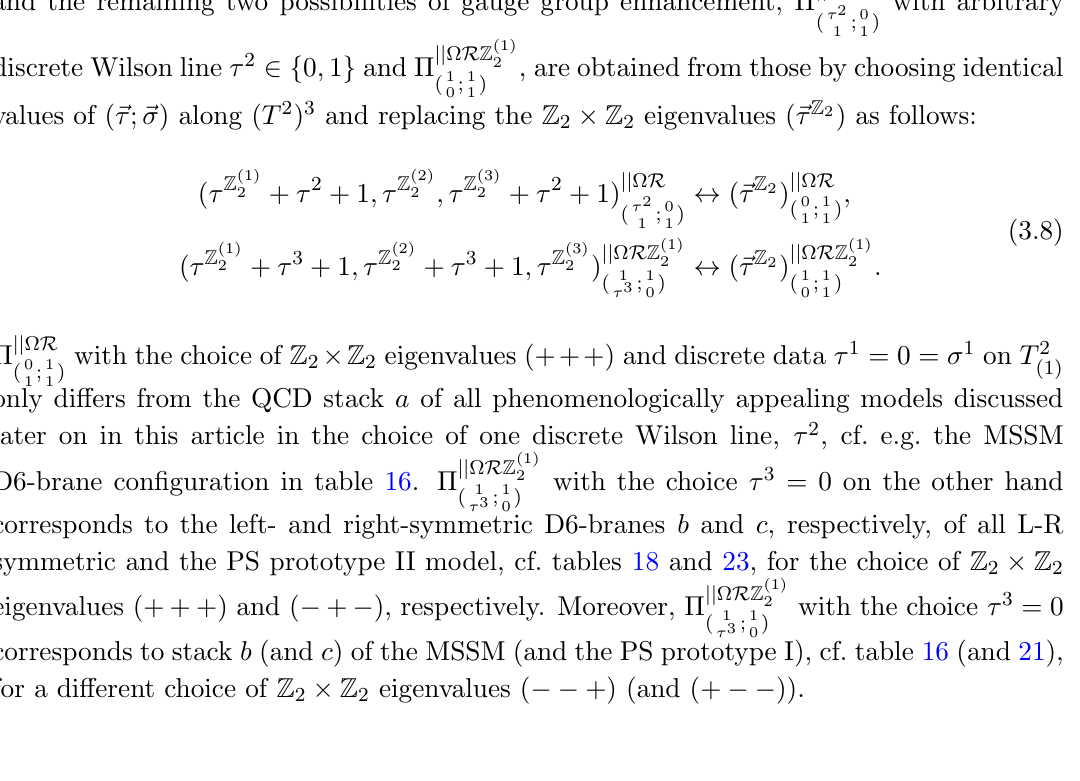
(+4 Z ) twisted complex 2 3 ; 6